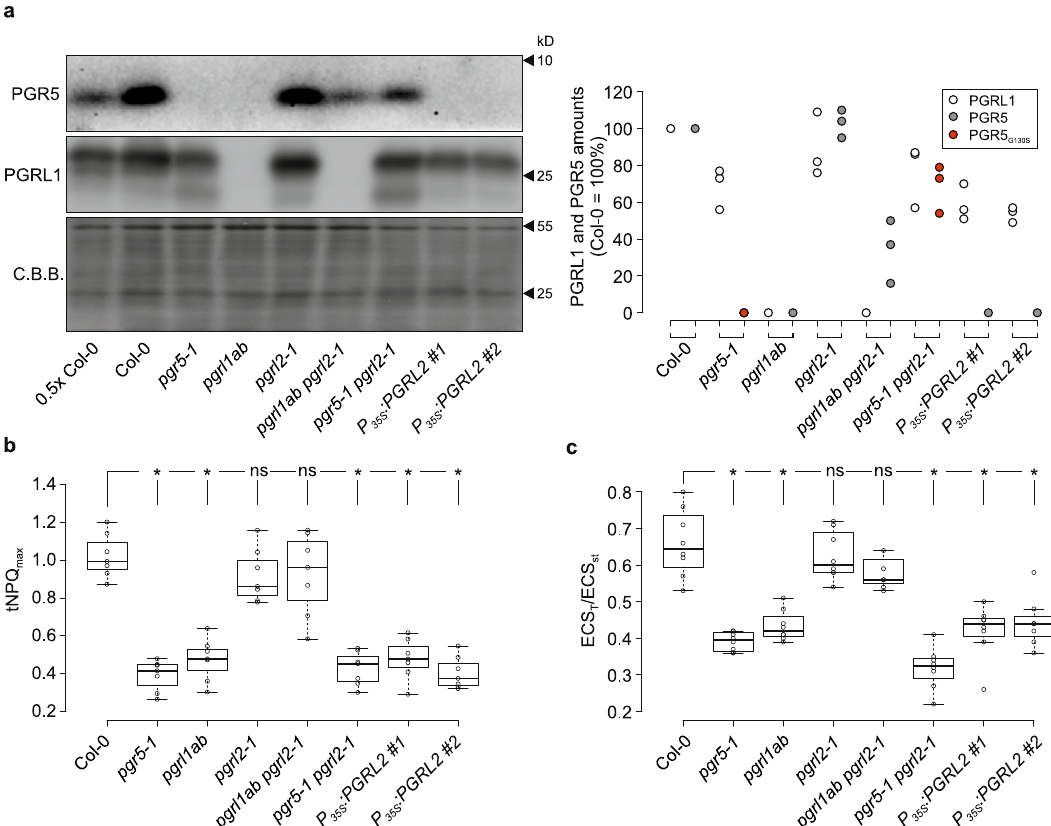
Fig. 3 PGR5 can mediate CEF in the absence of PGRL1. a Aliquots of leaf proteins prepared from CL plants shown in Fig. 2 were fractionated by SDS-PAGE and subjected to immunoblotting using PGR5- or PGRL1-speci fi c antibodies. PVDF membranes were stained with Coomassie brilliant blue (C.B.B.) as loading control. Quanti fi cation of PGRL1, PGR5, and PGR5 G130S amounts from three experiments (WT = 100) are shown as dot plots on the right. b Maximal transient NPQ (tNPQ max ) values determined during dark-to-light (110 µ mol photons m − 2 s − 1 ) transitions (see “ Methods ” ). Data points are shown as open circles ( n = 7). c Electrochromic shift (ECS) was measured to assess the proton motive force (PMF) (see “ Methods ” ). Plants were exposed to high light intensities (340 µ mol photons m − 2 s − 1 ) for 15 min, and the change in absorbance at 515 nm (ECS T ) was recorded in dark interval relaxation kinetics. ECS T values were normalized to the ECS st , the absorbance change at 515 nm evoked by a single turnover fl ash prior to exposure to high light levels. Data points are shown as open circles ( n = 8, 8, 8, 8, 7, 8, 8, 8). The horizontal lines in b , c represent the median, and boxes indicate the 25th and 75th percentiles. Whiskers extend 1.5× the interquartile range, outliers are represented as dots. For statistical analyses in ( b , c ), the non- parametric Kruskal – Wallis test was performed, followed by pairwise Dunn ’ s tests. The p -values were adjusted on an experiment level using the Benjamini – Hochberg method. Statistically signi fi cant differences are marked with asterisks (* p ≤ 0.05, ns, not statistically signi fi cant). P -values in b (order as displayed): 6.8 × 10 − 4 , 3.6 × 10 − 3 , 0.4, 0.4, 1.4 × 10 − 3 , 3.6 × 10 − 3 and 9.1 × 10 − 4 . P -values in c (order as displayed): 1.8 × 10 − 4 , 4.7 × 10 − 3